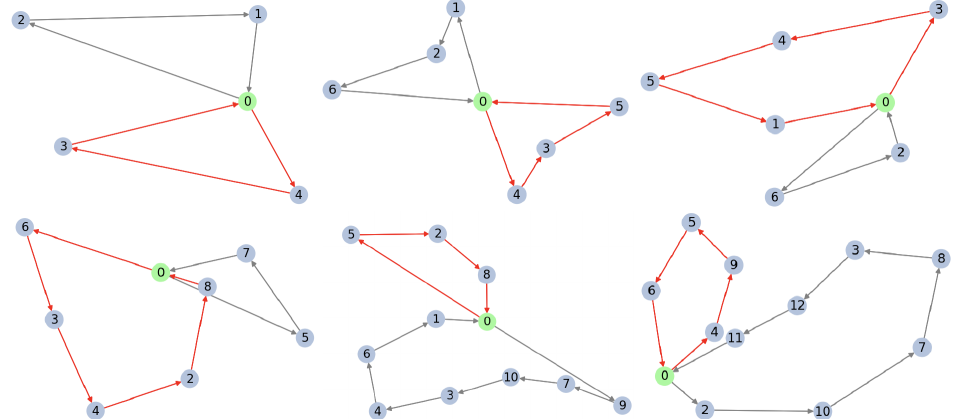
Figure 3. In these graphs, we can observe the algorithm’s results in different scenarios of the VRP formulation. We can follow the correct scalability of the algorithm. We provide the code [50] to verify the proper functioning of the formulation. Vehicle number 1 is red, and the next is light-steel-blue. While the depot is the 0 node in pale-green colour, and the rest are represented in light-steel-blue. In this case, we have variables cities from 4 to 12 and using up to 2 vehicles. It is important to highlight that this VRP minimises the time travelled by the cars. The number of qubits used is 2418 to test the last case. Table 1. A regular polygon layout has been taken where the cities occupy the positions of the nodes [50] for the elaboration of all tables. In this scenario of 4 cities, we set comparison with the 3 models, MTZ, native TSP and GPS. The comparison is based on the number of times to find the solution, the distance travelled, and the number of qubits. We can appreciate the good performance of our GPS model, and above all the savings it offers us in the number of qubits.